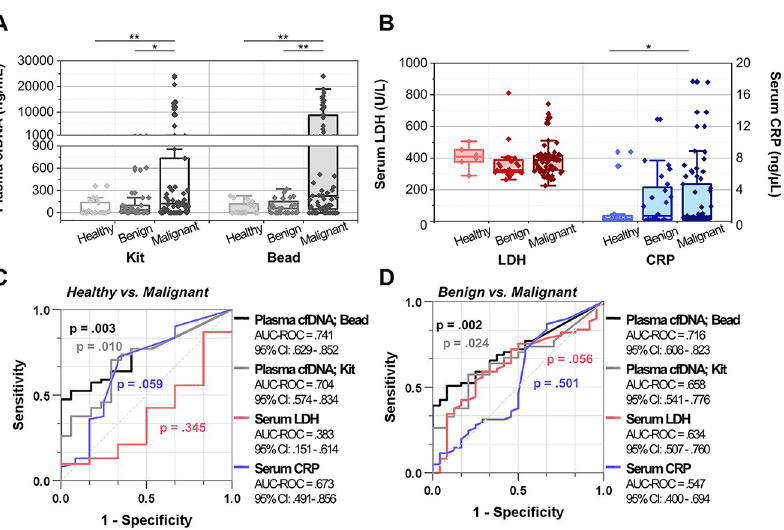
Fig 2. Plasma cfDNA and serum antigen levels quantified from a total of 85 patients with gastric tumor, 61 with malignant tumor and 24 with benign tumor, and 17 healthy individuals. (a) The amount of plasma cfDNA levels measured from each cohort using the new bead-based cfDNA separation system and commercially available QIAamp DNA mini kit. (b) The amount of serum LDH and CRP levels measured from each cohort. (c, d) The diagnostic capability of the new cfDNA separation platform compared with commercially available QIAamp DNA mini kit and other serum antigen blood tests. The new bead-based system demonstrated the highest performance in distinguishing the patients with malignant tumor from both (c) healthy donors and (d) patients with benign tumor.